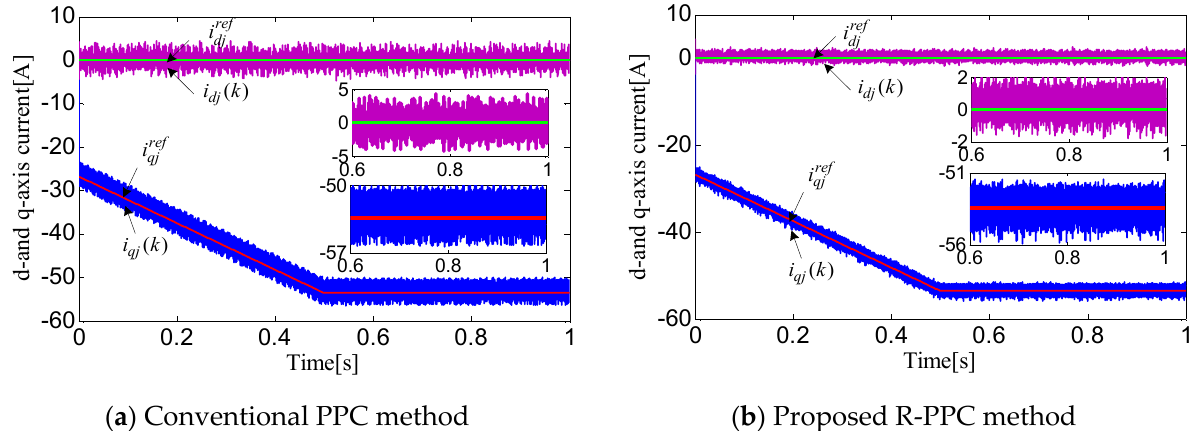
Figure 12. Simulation results of the d- and q-axis current under the discharge state. ( a ) Conventional PPC method; ( b ) Proposed R-PPC method.